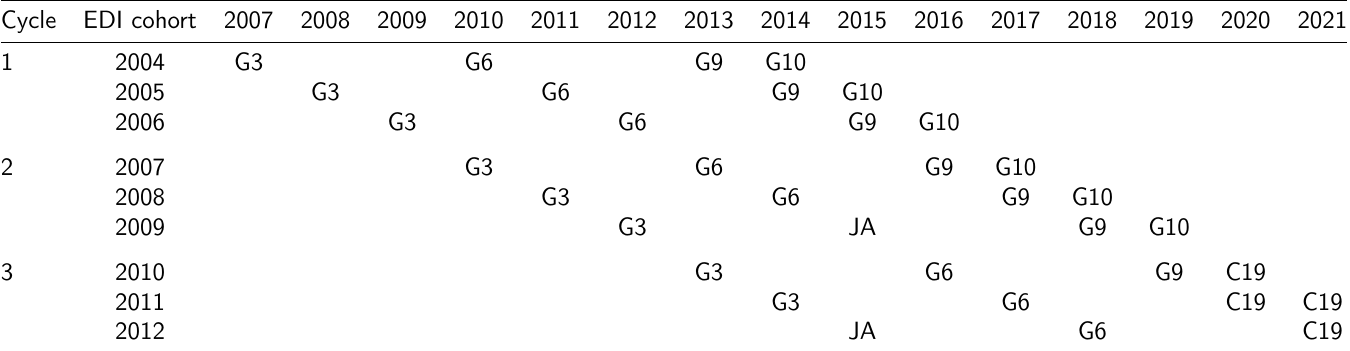
Table 1: EDI and EQAO components merged into multi-cohort time-series database